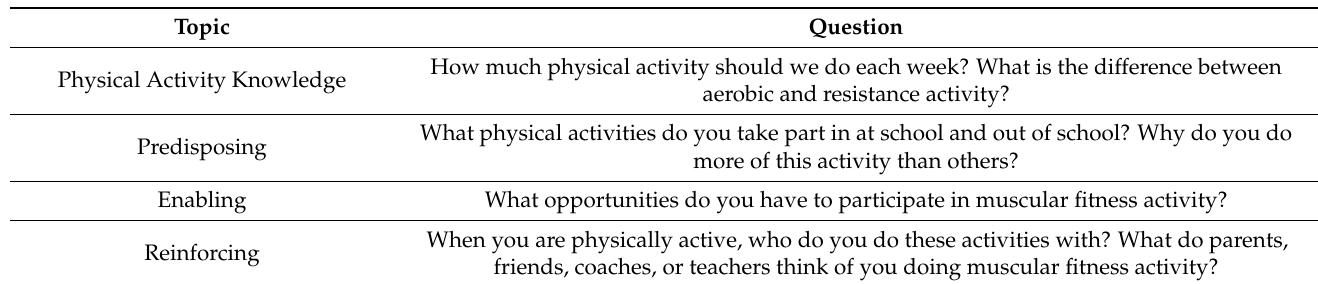
Table 1. Example write, draw, show, and tell